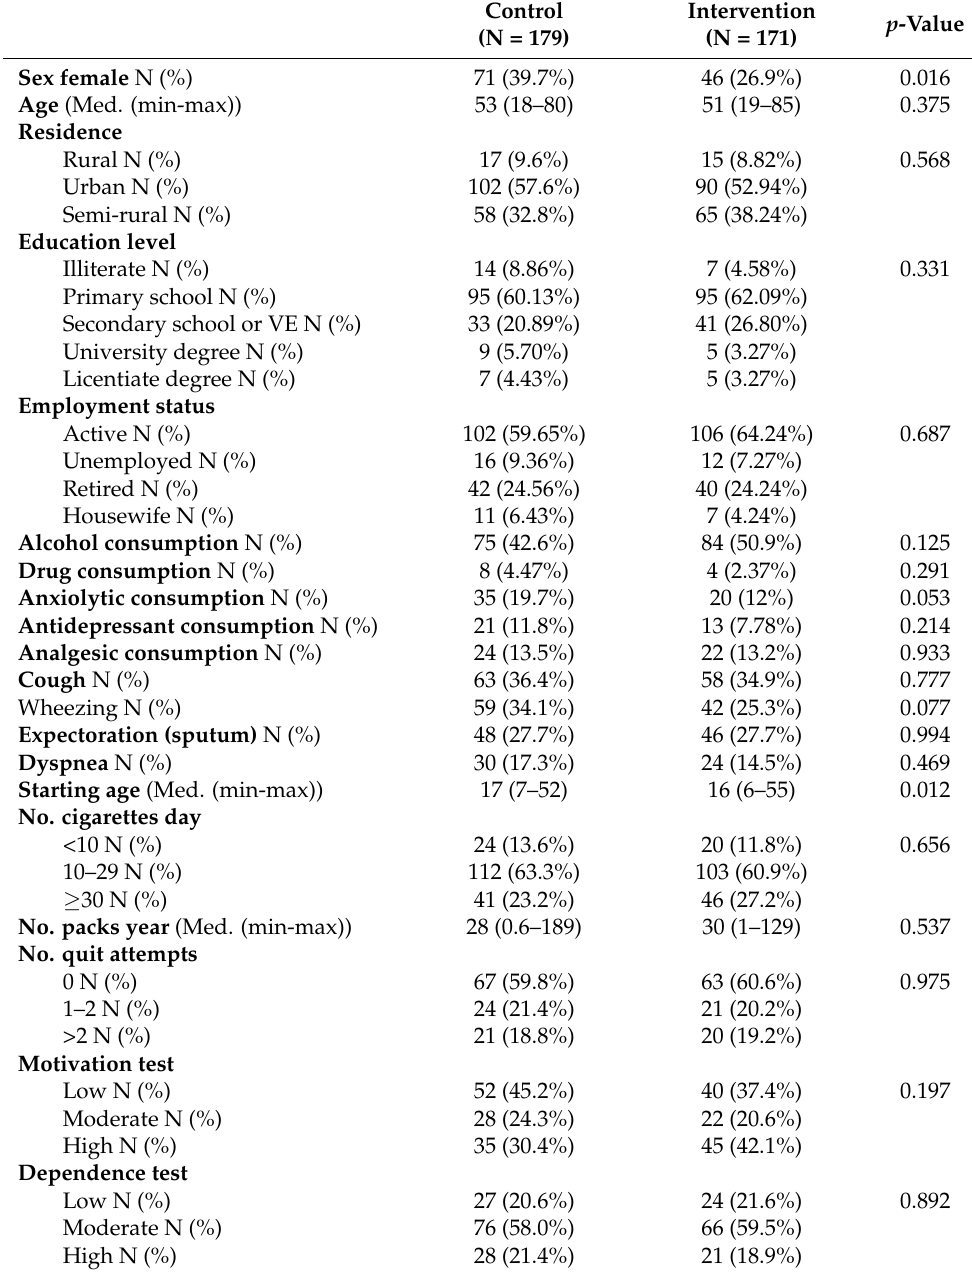
Table 1. Characteristics of participants at baseline, according to randomized group